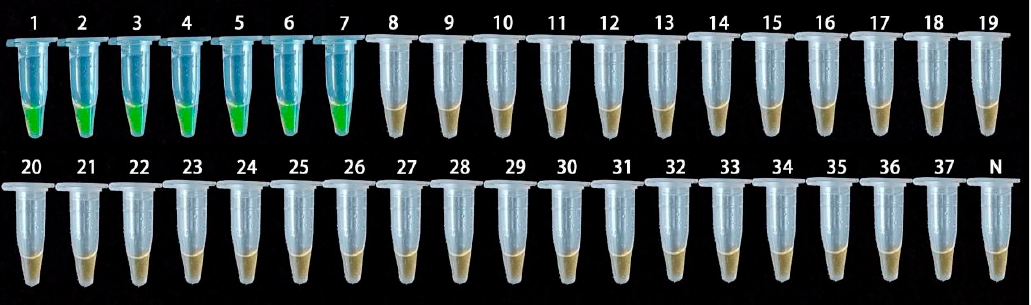
Figure 8. Specific detection of Loop-mediated isothermal amplification (LAMP) primer; 1–37: the PCR tube number corresponds to the DNA of the tested strain in Table 3; N: negative control.